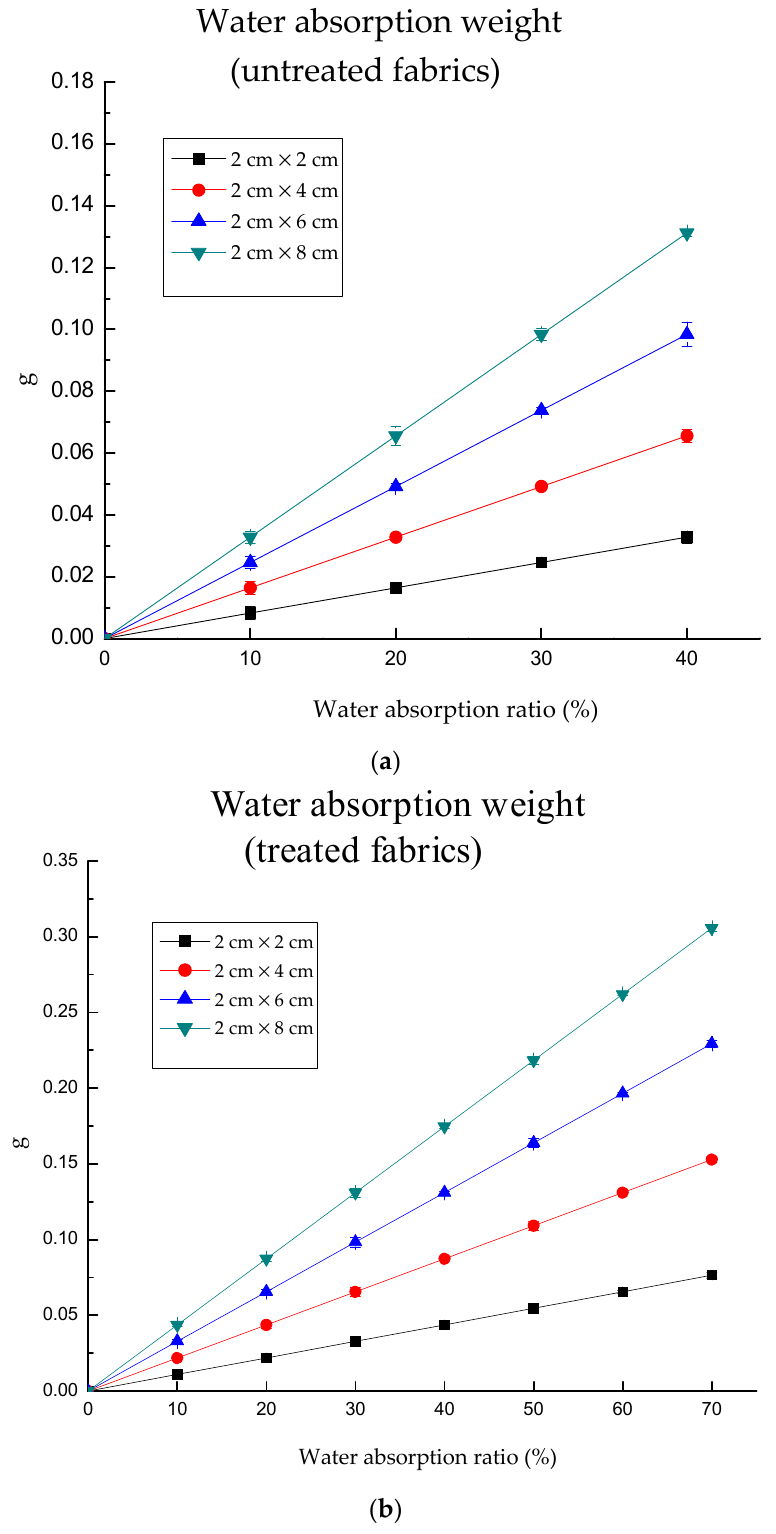
Figure 5. The water absorption weight of untreated and treated fabrics. ( a ) the maximum values of water absorption weight of the untreated fabric are about 0.13 g for 2 × 8 cm at 40% water absorption ratio; ( b ) the maximum values of water absorption weight of the untreated fabric are about 0.3 g for 2 × 8 cm at 70% water absorption ratio. When comparing the values under each wet condition with the dry condition ( ∆ log r /log r 0 × 100%), there was a decline for all 4 sample sizes. As Figure 6a,b shows, the curves